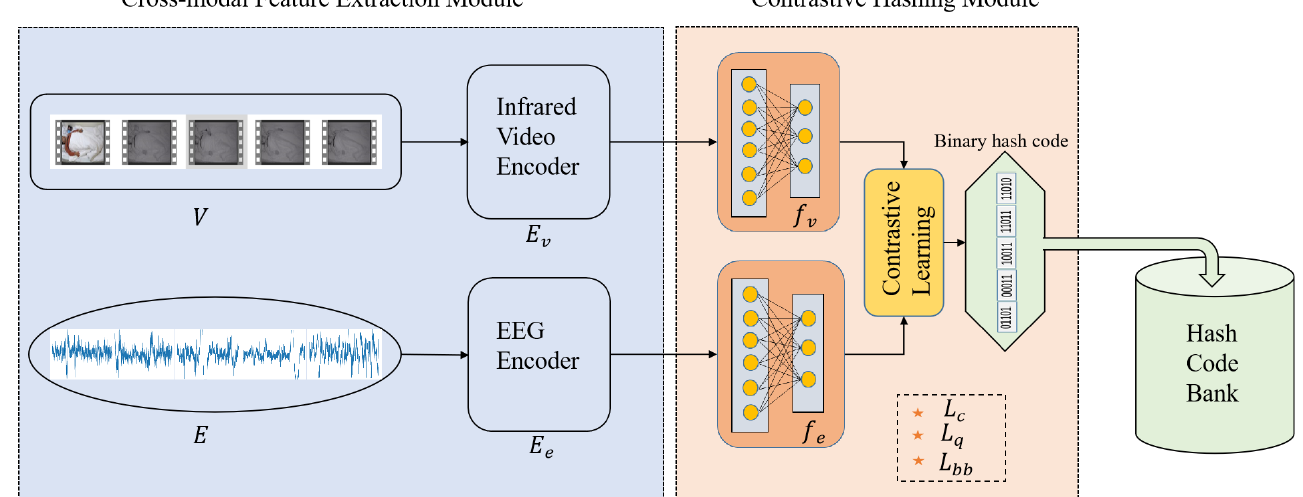
Figure 3. Overview of the proposed Cross-modal Contrastive Hashing Retrieval method. The pipeline of our method consists of two components: Cross-modal Feature Extraction Module that extract deep semantic features from the raw clips of IR videos and EEG modalities; Contrastive Hashing Module that achieve consistency in cross-modal representation and generate unique binary hash code to facilitate